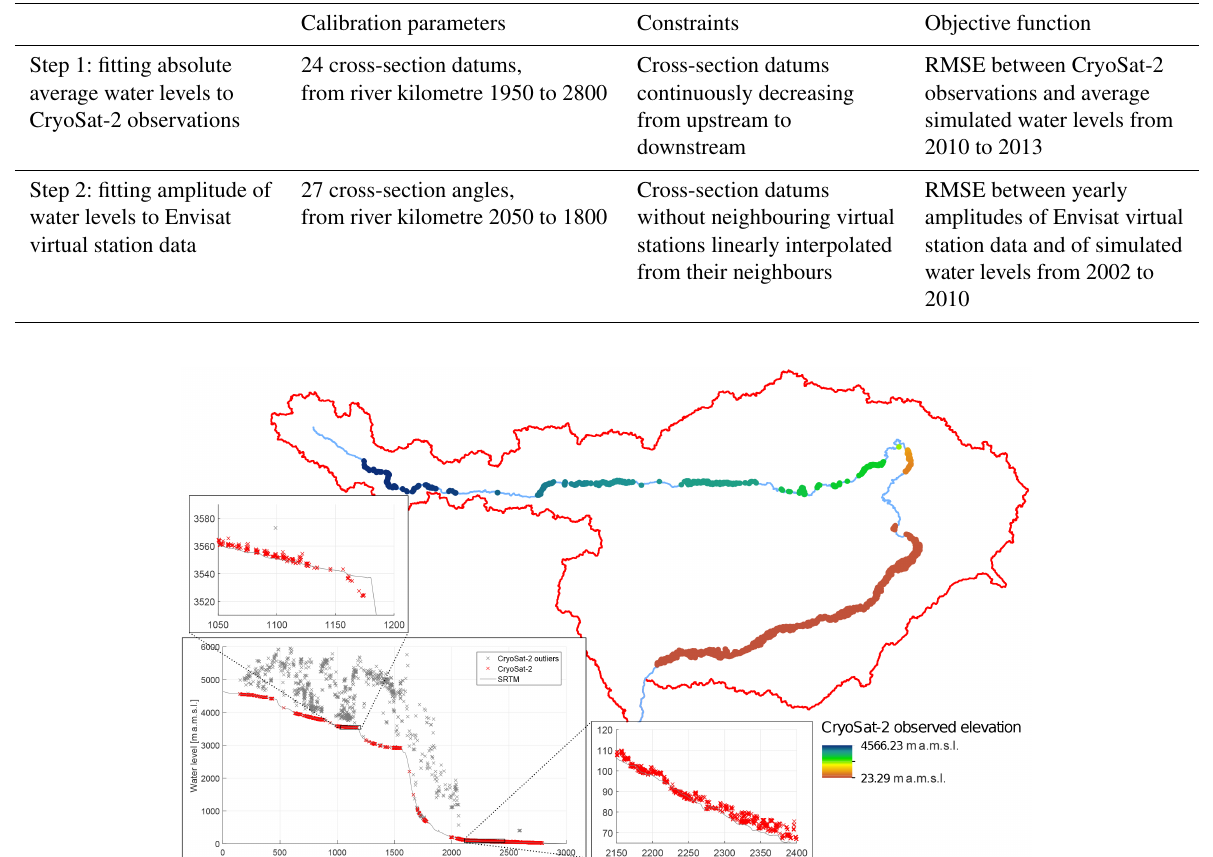
Table 1. Decision variables, constraints, and objective functions of the genetic algorithm used for the two-step cross-section calibration.